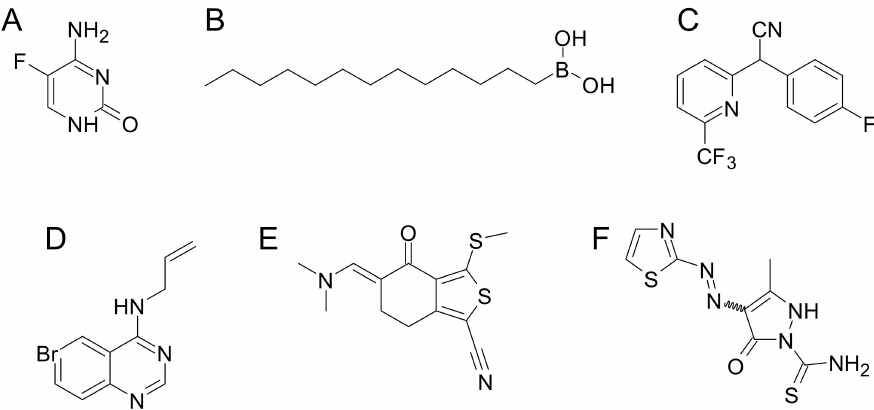
Figure 8. Chemical structures of the principal pyoverdine inhibitors: ( A ) the biosynthesis inhibitor 5-fluorocytosine; ( B – D ) n -alkylboronic acid, biaryl nitrile and quinazolamide PvdQ inhibitors; ( E , F ) pyoverdine